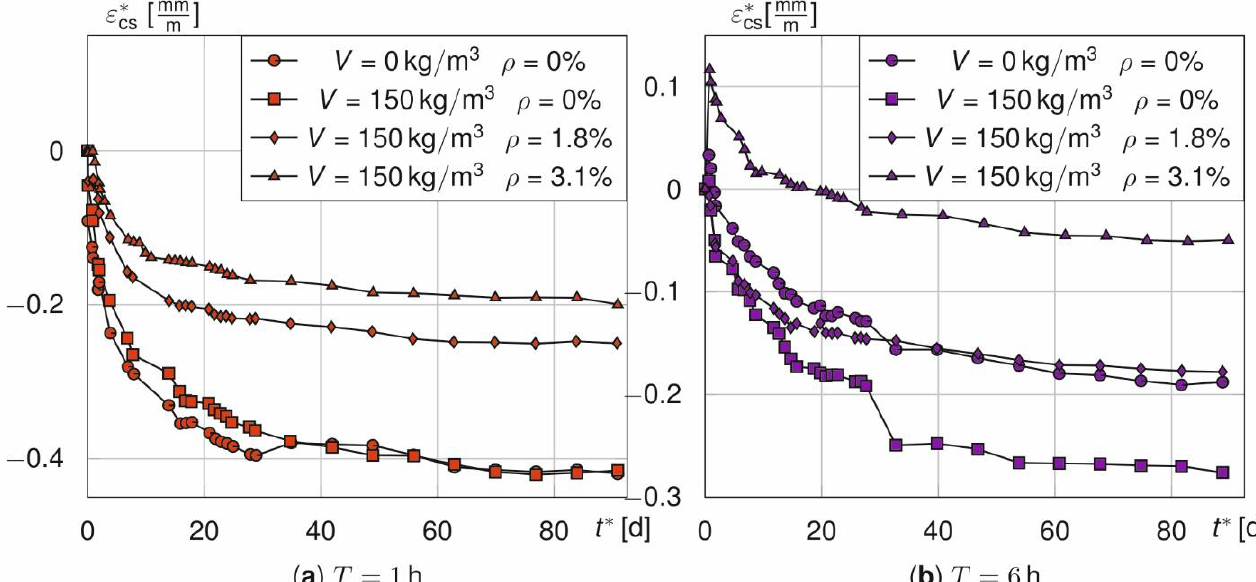
Figure 9. Shrinkage strain ε cs * of prisms and beams for T = 1 h ( a ) and T = 6 h ( b ). Shrinkage curve